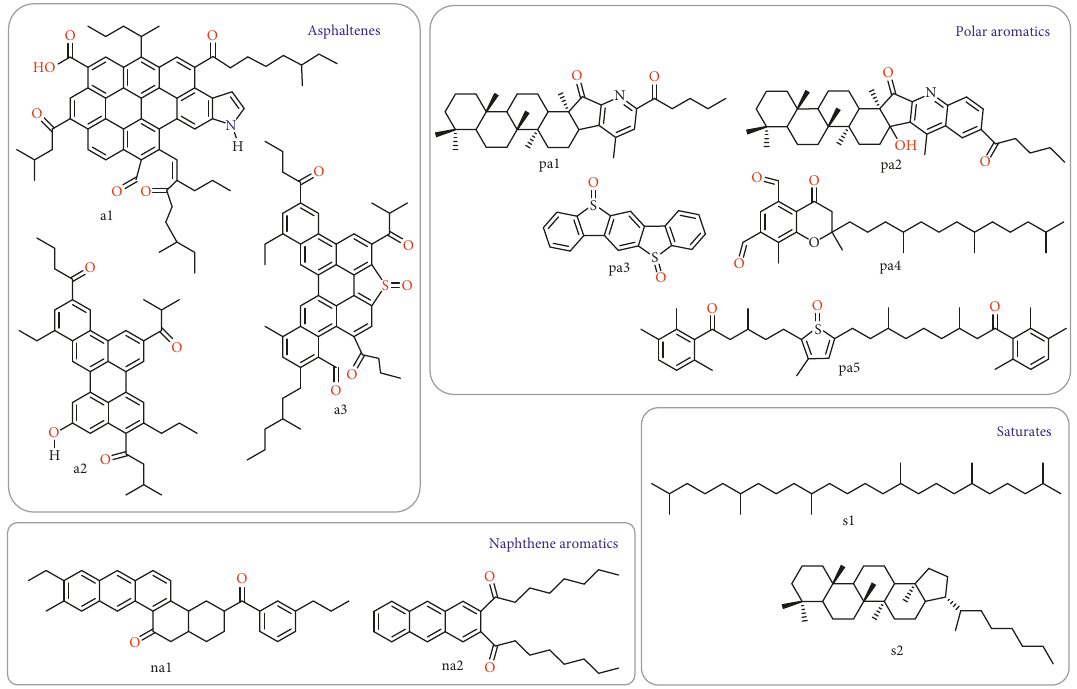
Figure 6: Molecular structures of various asphalt components at the end of the ReaxFF MD